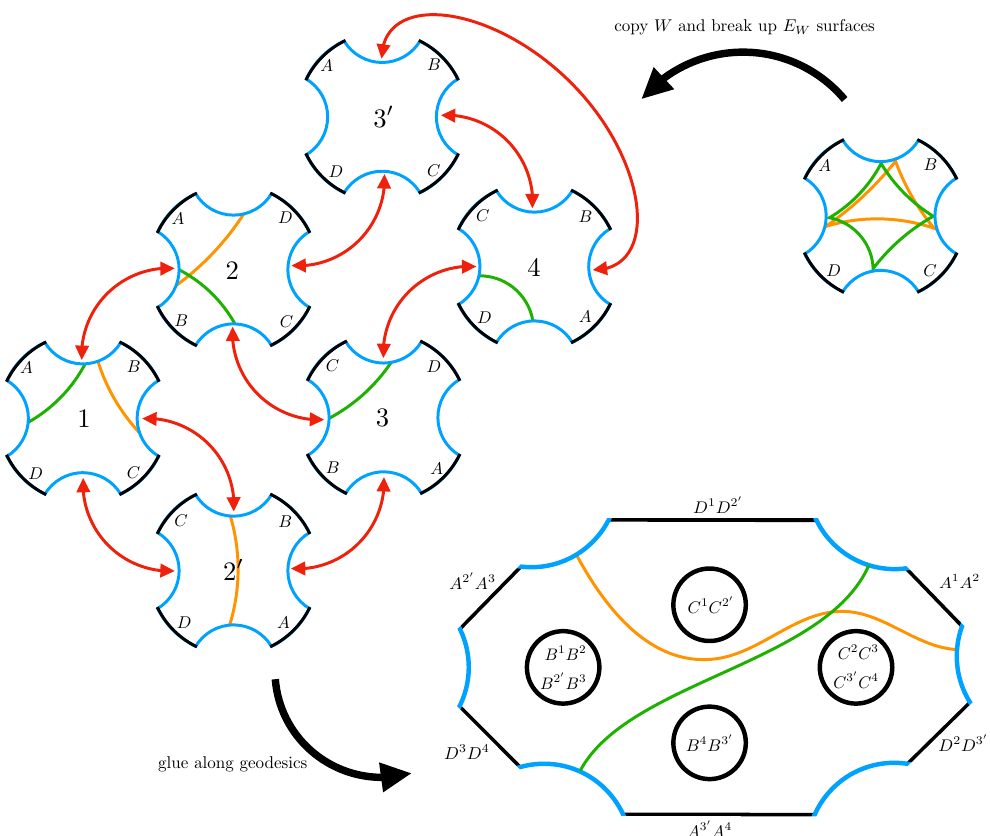
Figure 3 . The entanglement wedge of A, B, C, D is replicated and glued to form a manifold M 0 on which multipartite entanglement wedge cross sections are mapped to ( A, D ) -anchored geodesics. For illustration, the surface corresponding to E W ( A : B : C : D ) is mapped to a geodesic that subtends A 1 A 2 A 3 0 A 4 B 3 0 B 4 C 2 C 3 C 3 0 C 4 D 2 D 3 0 (shown in green), and the surface corresponding